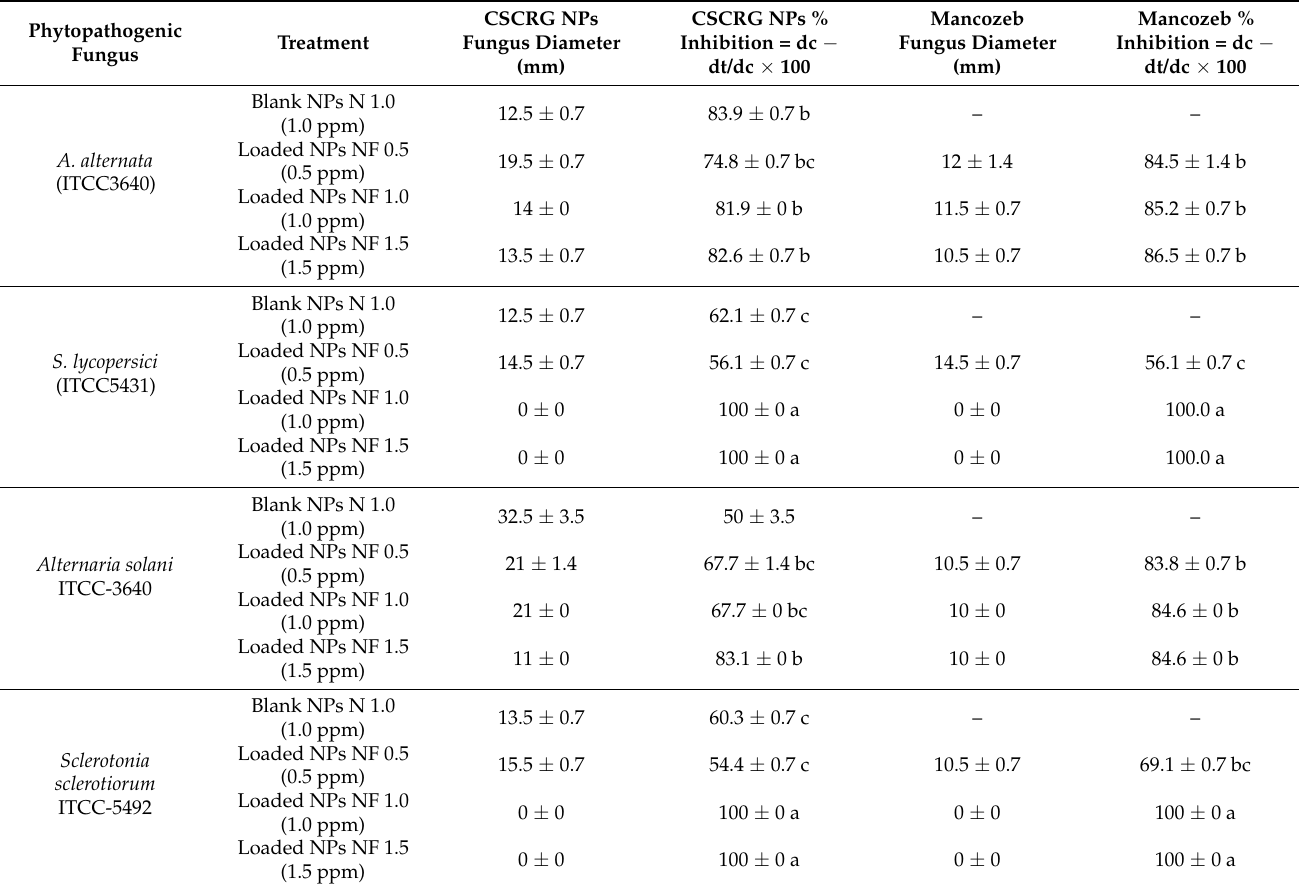
Table 3. In vitro antifungal activity of blank and mancozeb-loaded (1.0 mg/mL) CSCRG